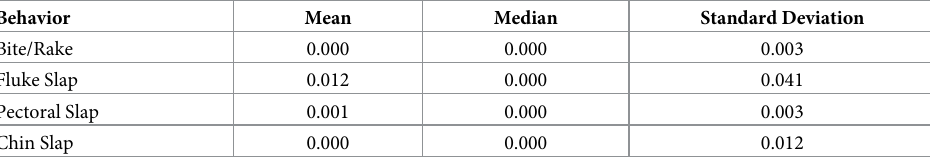
Table 3. Descriptive statistics highlighting the rates of aggression recorded during the